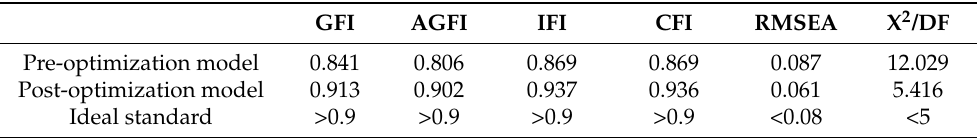
Table 2. Comparison of fit index before and after model optimization.